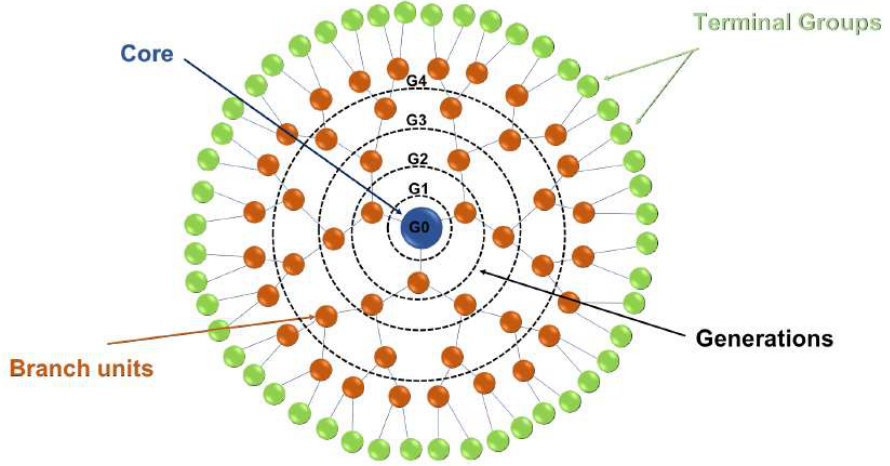
Figure 1. Structure of dendrimer: The blue sphere (G0) is the core of the dendrimer. Branching units are marked in orange. Starting from the core, the generations are extended and labeled as G1–G4. The outermost layer contains the dendrimer’s terminal groups (green).